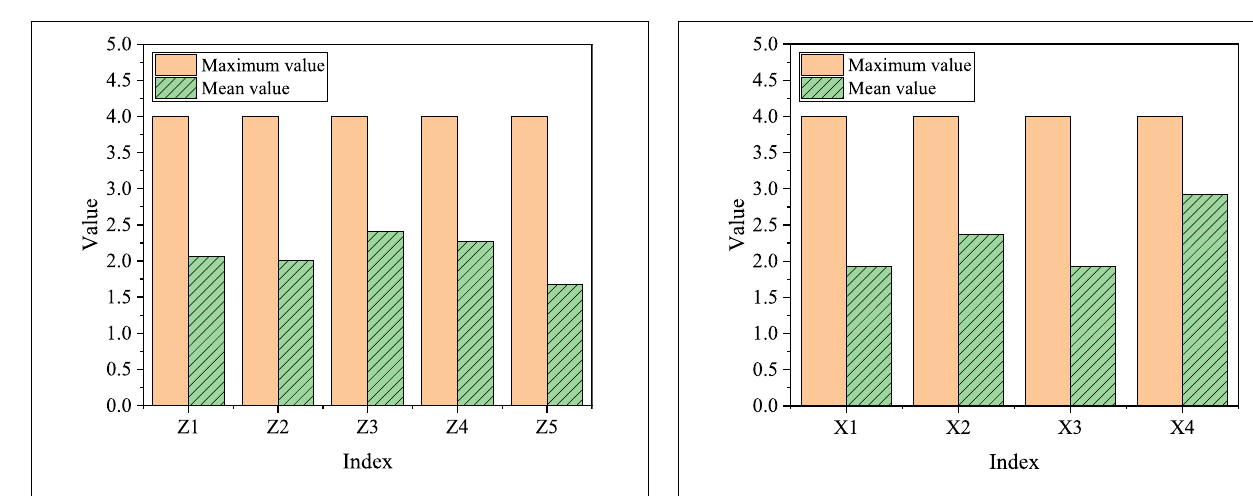
FIGURE 10 | Evaluation and statistics of college students’ entrepreneurial environment.